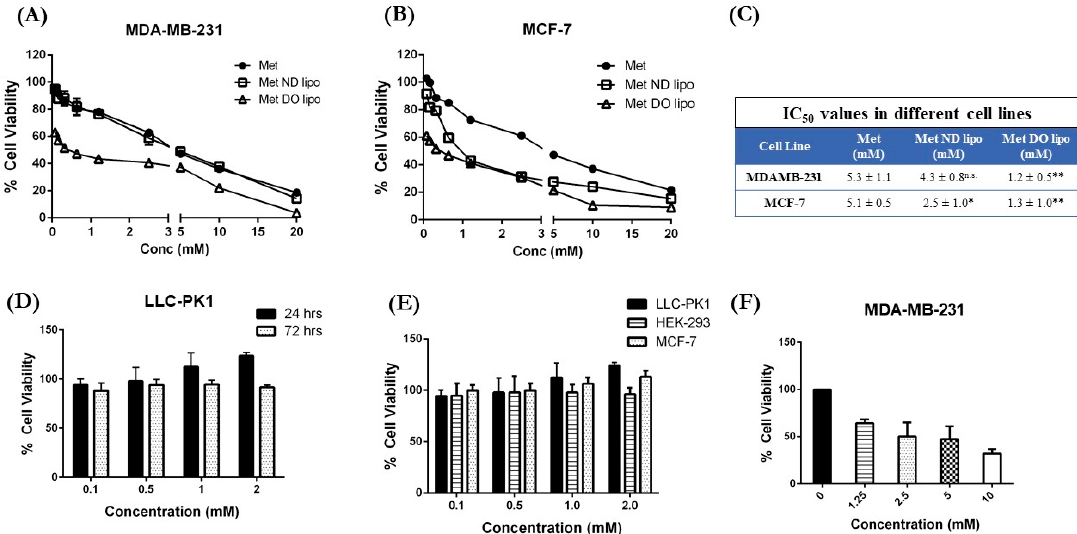
Figure 5. Cytotoxicity studies of Met-loaded liposomes determined using MTT assay after 72 h incubation with treatment in two different breast cancer cell lines: ( A ) MDA-MB-231 and ( B ) MCF-7; ( C ) IC 50 values for each treatment in both cell lines; ( D ) Blank 1,2-dioleoyl-3-trimethylammonium-propane (DOTAP) liposomes cytotoxicity evaluated on LLC-PK1 cell lines; ( E ) % Cell viability of blank DOTAP liposomes evaluated after 24 h of incubation in LLC-PK1, HEK-293, and MCF-7 cells; ( F ) Met Do lipo cytotoxicity in MDA-MB-231 after 6 h of incubation. Data represent mean ± SD of three individual experiments with n = 6 for each trial. * p < 0.05 and ** p < 0.01 vs. Met.